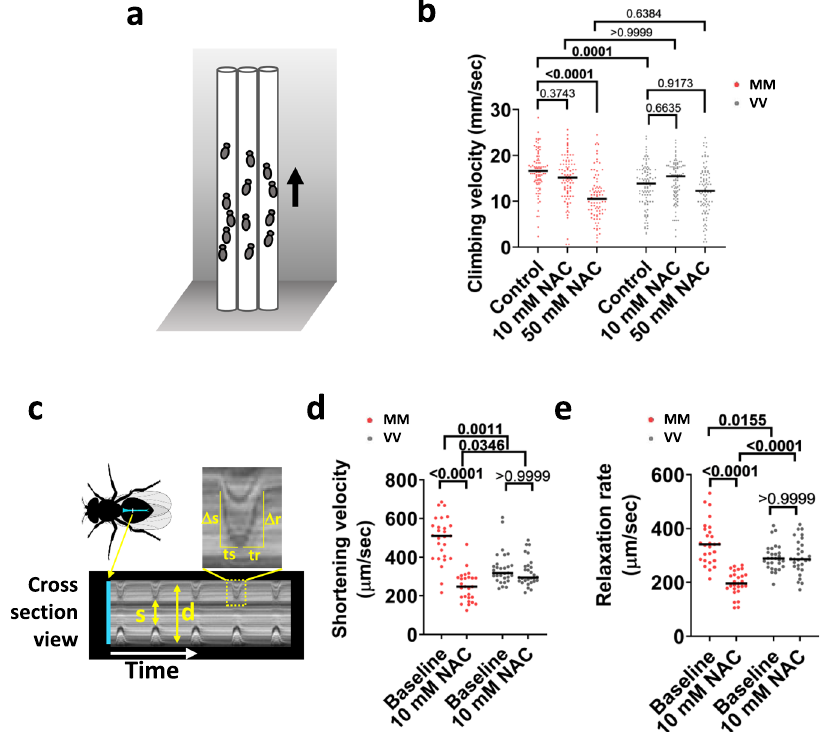
Fig. 5 MM module couples ROS to improved performance in Drosophila melanogaster . a Diagram for the climbing test. b Vertical climbing velocity of fl ies treated by control food (5% sucrose) or food containing 10 mM or 50 mM NAC for 24 h; n = 93 control-treated MM, n = 90 10 mM NAC-treated MM, n = 86 50 mM NAC-treated MM, n = 94 control-treated VV, n = 91 10 mM NAC-treated VV, n = 94 50 mM NAC-treated VV. Horizontal lines indicate medians. P values shown above the brackets, Dunn ’ s nonparametric multiple comparisons tests, two-tailed. c Diagram of a fl y heart (in blue color) and an example kymograph recording of heart dynamics. Arrows indicate systole (s) and diastole (d) of the heart. The boxed region of the kymograph was magni fi ed to show that the shortening velocity was derived from Δ s/ts, and the relaxation rate was derived from Δ r/tr. d and e Cardiac performance indices of MM and VV hearts before and after 60-min treatment by 10 mM NAC. The shortening velocity d and relaxation rate e were assessed; n = 27 MM hearts per condition and n = 29 VV hearts per condition; horizontal lines indicate medians; P values shown about the brackets in d and e , two-tailed tests; Dunn ’ s nonparametric multiple comparisons tests for d , and Welch ’ s ANOVA test followed by Dunnett ’ s T3 multiple comparisons test for e ; choice of tests was determined by data normality. Source data are provided in the Source Data fi